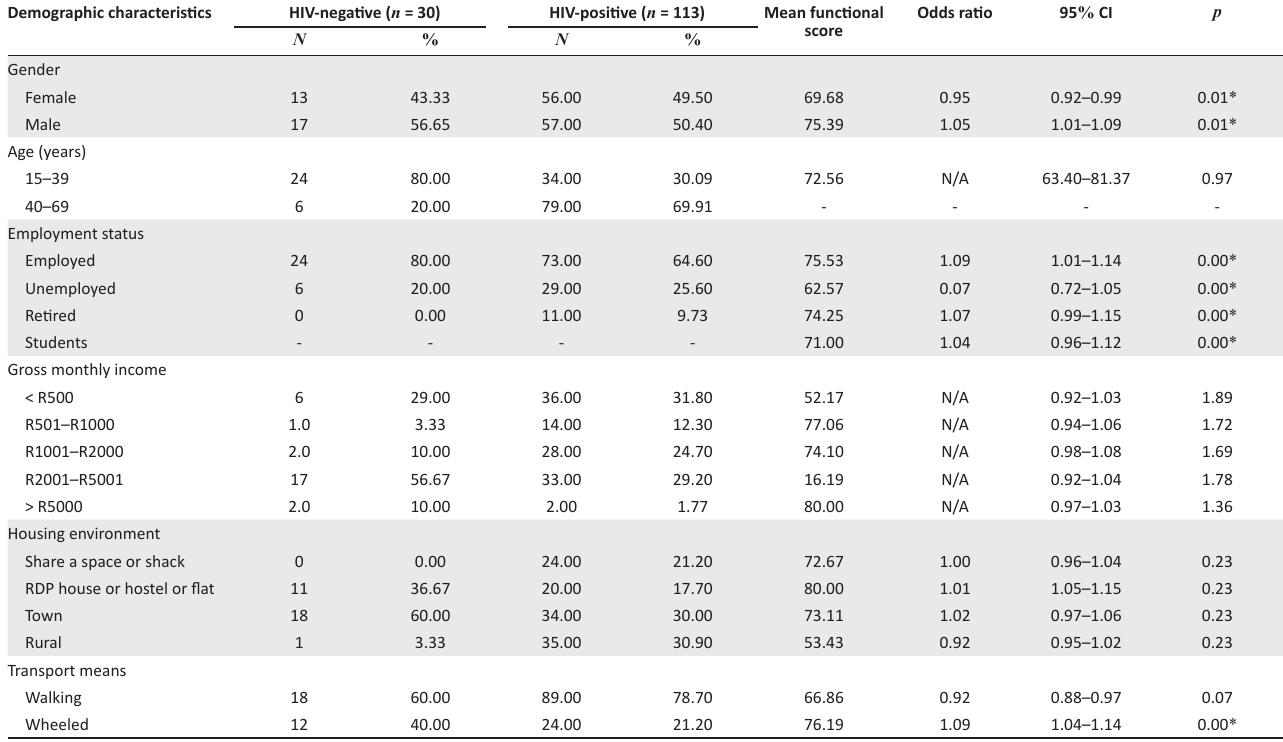
TABLE 1: Age and gender characteristics and their relationship to functional status for HIV-negative and HIV-positive groups ( n = 143). Demographic